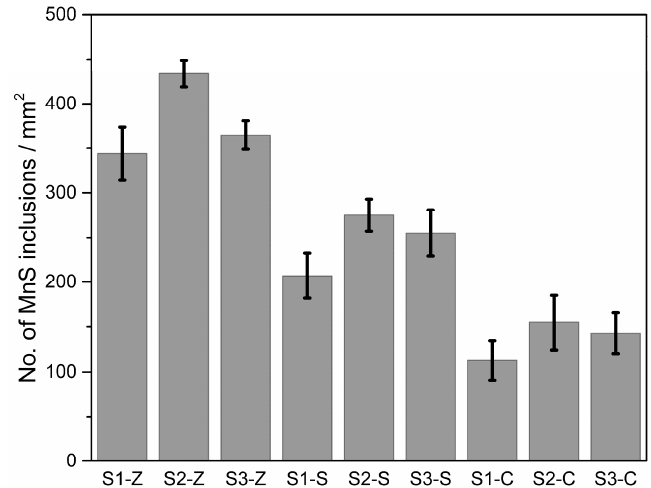
Figure 7. Statistical analysis of the quantity of MnS particles. Error bars are ± one standard deviation.